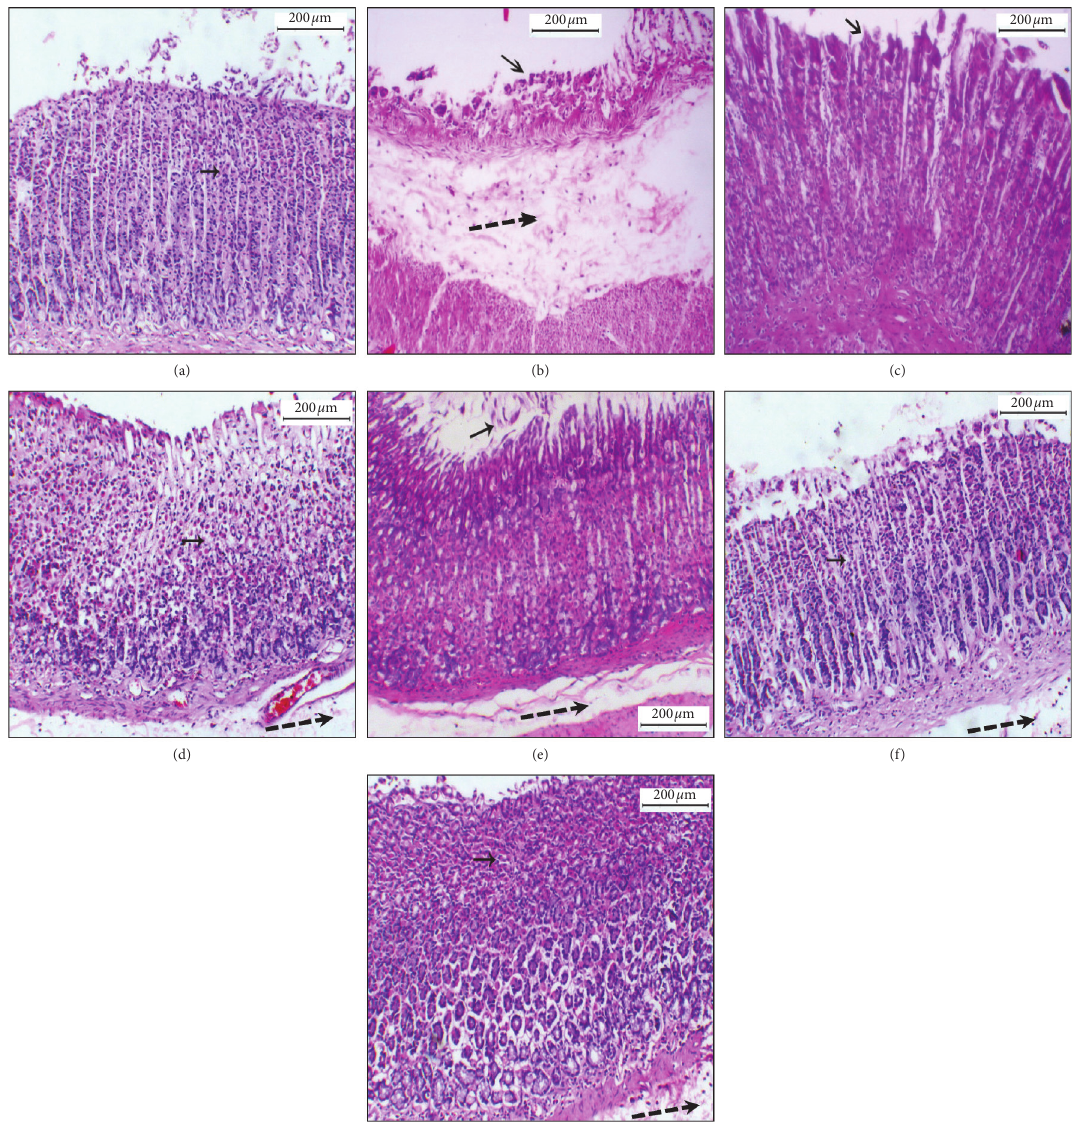
Figure 4: Effect of QP, QG, QB, and QF on the microscopic hematoxylin and eosin (H&E) staining of stomach sections. (a) Normal stomach. (b) Stomach treated with absolute EtOH at dose of 5mL/kg showing intense ulceration and degeneration of upper gastric mucosa (small straight arrow) along with necrotic gastric glands (double-lined arrow) and swollen edematous submucosa (dashed arrow). (c) Stomach treated with omeprazole (20mg/kg) showing significant reduction in the damage of the upper mucosa (straight arrow) and maintained gastric glands. (d) Stomach treated with QP (quinoa seeds cooked under high pressure, 200 mg/kg) showing moderated ulceration and upper mucosal degeneration. (e) Stomach treated with QG (first stage-germinated quinoa seeds, 200mg/kg) showing mild necrosis of gastric glands. (f) Stomach treated with QB (quinoa seeds fermented by Lactobacillus plantarum bacteria, 200mg/kg) showing minor damage of the gastric mucosa. (g) Stomach treated with QF (quinoa seeds fermented by Rhizopus oligosporus fungus, 200mg/kg) showing mild mucosal